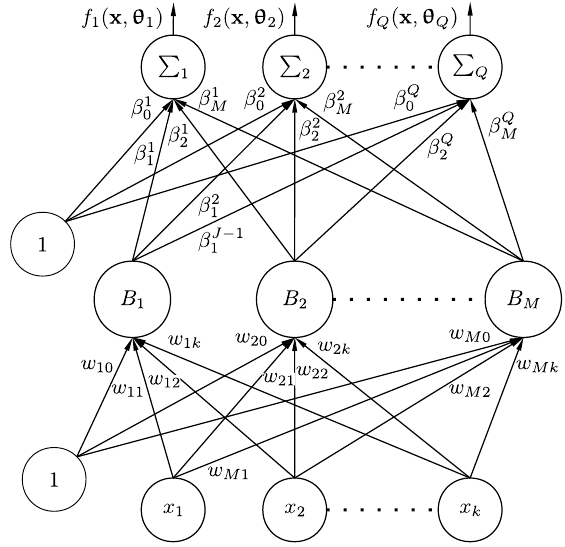
Figure 3. Architecture of an ANN for classification problems with M basis functions and Q